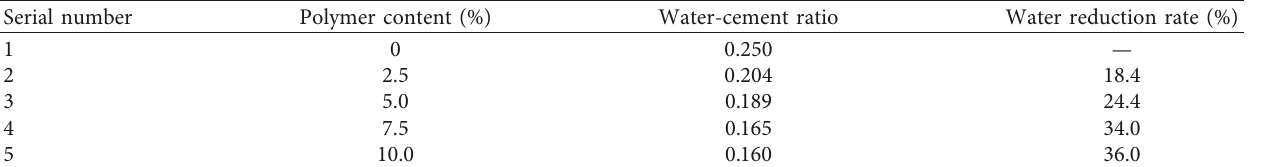
Table 4: Mixture ratios and water reduction rates of emulsions in cement paste.